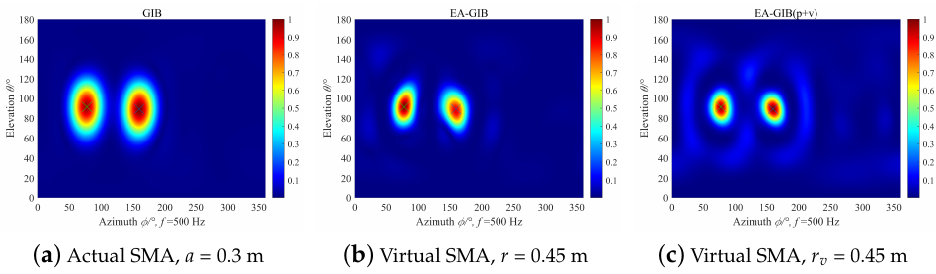
Figure 8. Simulation results of the double sound source with the frequency 500 Hz.